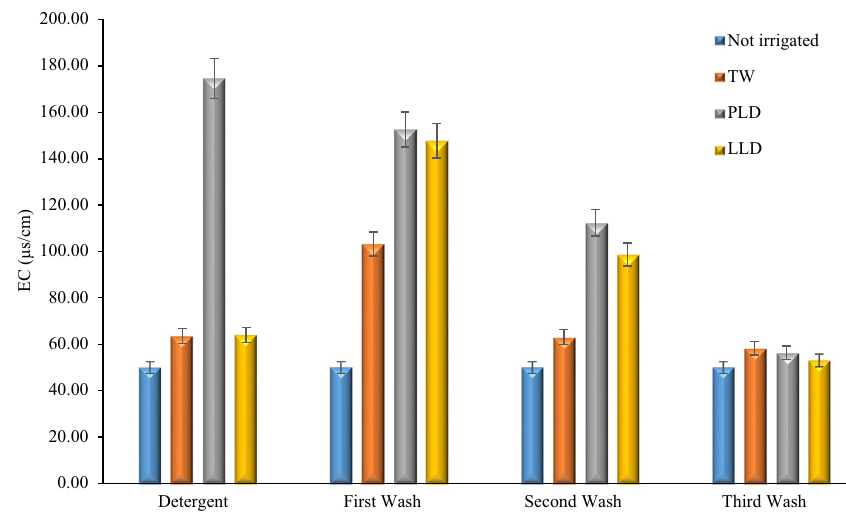
Fig. 2 EC of soil leachate after irrigated with tap water (TW), powder laundry detergent (PLD) and liquid laundry deter- gent (LLD)